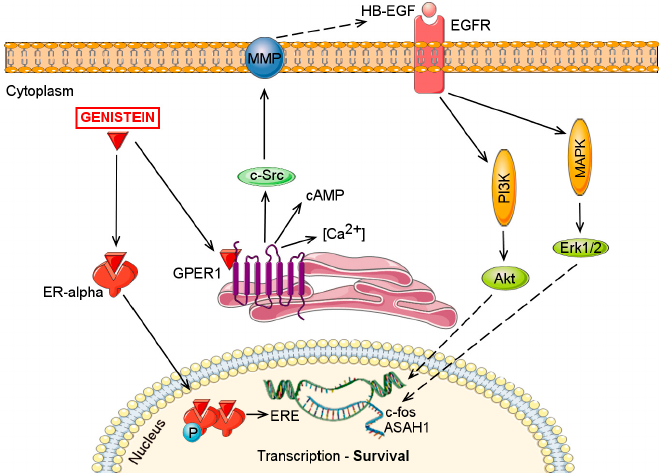
Figure 2. Genistein (0.01–10 μ M) stimulates breast cancer cell proliferation acting through